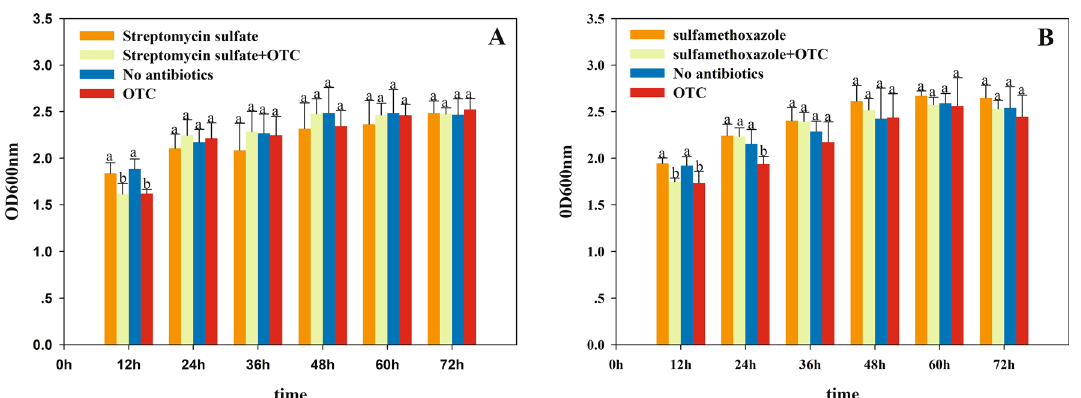
Figure 5. Effect of streptomycin sulphate ( A ) and sulfamethoxazole ( B ) on the growth of strain OTC-16. Different letters above error bars indicate significant differences ( P < 0.01) among